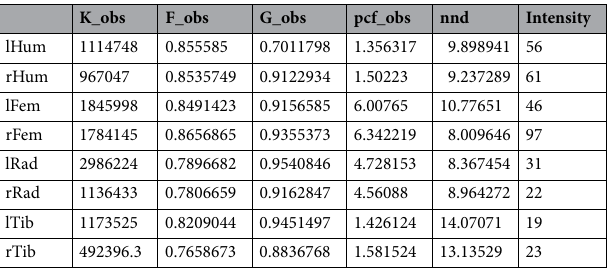
Table 2. Average values for observed data in each second-order function (K,G,F and pcf) and nearest- neighbour density (nnd) and